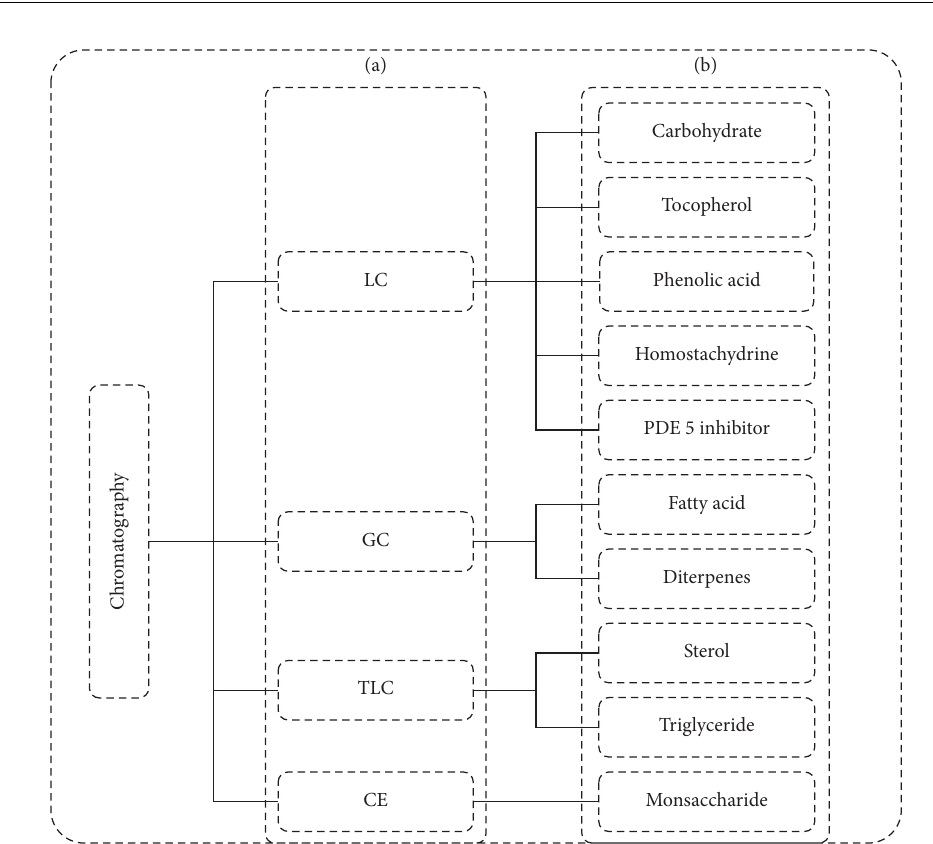
Figure 3: Quantitative chromatographic analysis of specifc marker compounds in cofee adulteration detection. (a) Common chro- matography. (b) Corresponding specifc marker